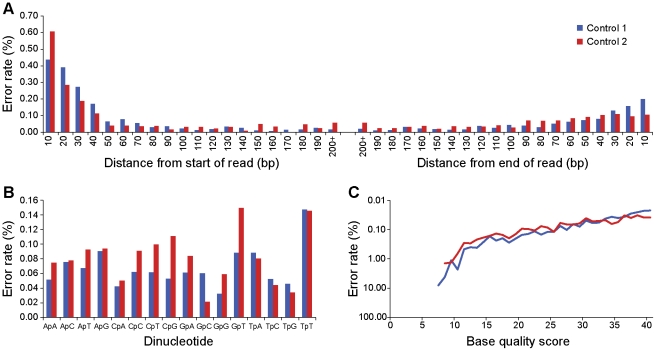
Error rates were not uniformly distributed.Error rates varied by (A) read position, (B) base transition, and (C) base quality score. We counted as errors any mismatches to the consensus assembly for each of the two runs in the control read set under the assumption that the NL-43 infectious clone had no diversity. We defined the read position relative to the beginning or end of the read, whichever was closer. We defined a base transition as a dinucleotide representing the transition from the preceding base to the current base, and we scored a transition as an error if the current base was a mismatch. Base quality scores came from the sequencing process.